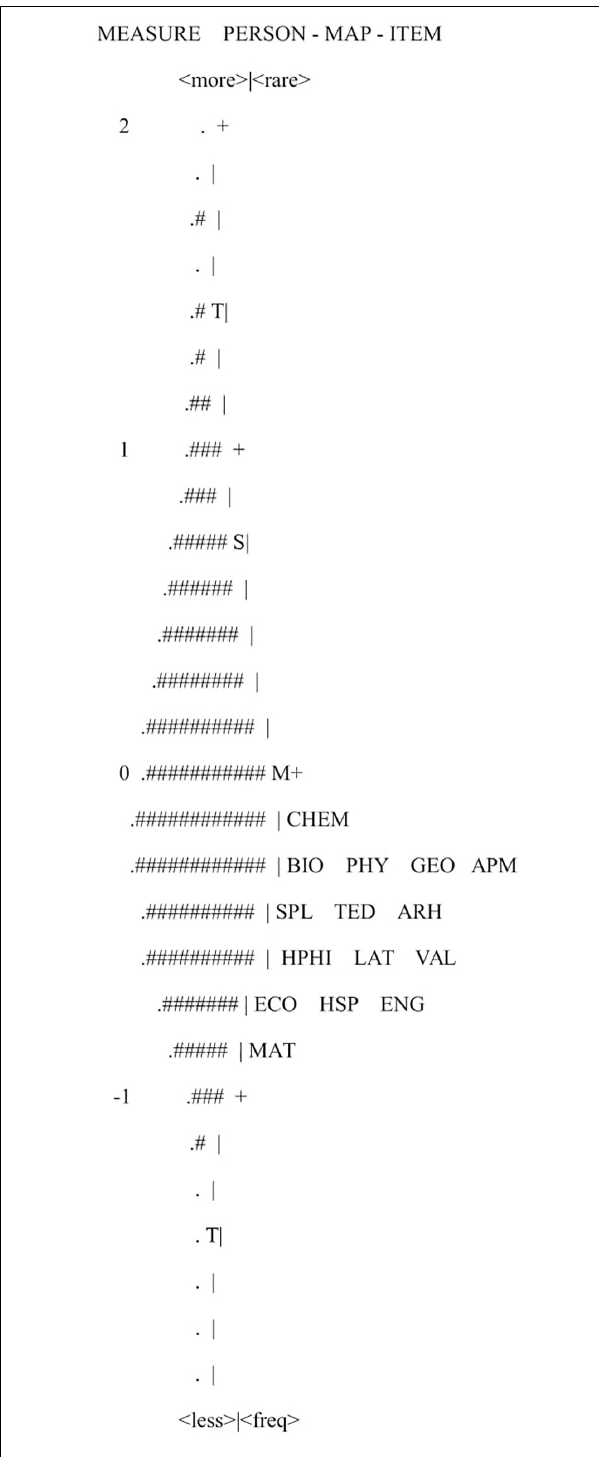
FIGURE 1 | Item-Person map. EACH “#” IS 146: EACH “.” IS 1 TO 145. CHEM, chemistry; BIO, biology; PHY, physics; GEO, geography; APM, applied mathematics to social sciences; SPL, spanish language; TED, technical drawing; ARH, art history; HF, history of philosophy; LAT, lating language; VAL, valencian language; ECO, economy; HSP, history of Spain; ENG, english language; MAT,